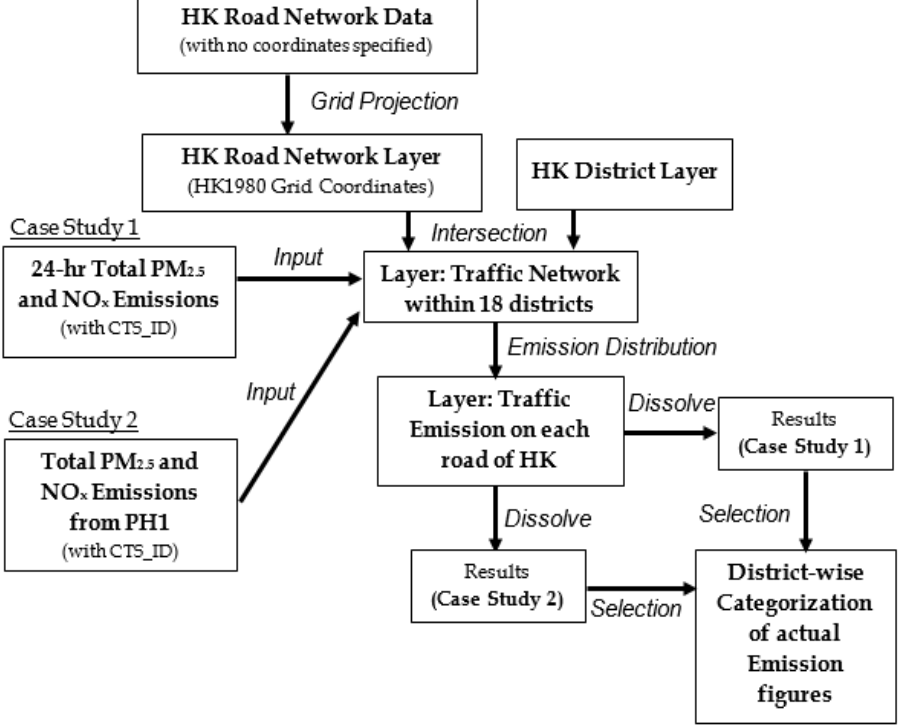
Figure 2. Framework and flowchart (indicated by the direction of arrows) of Case Studies 1 and 2, starting from grid projection to obtaining emission profiles. Descriptions in italics represent either the operation or geo-processing procedures within ArcGIS. HK: Hong Kong; PH1: The first defined period of peak hours .